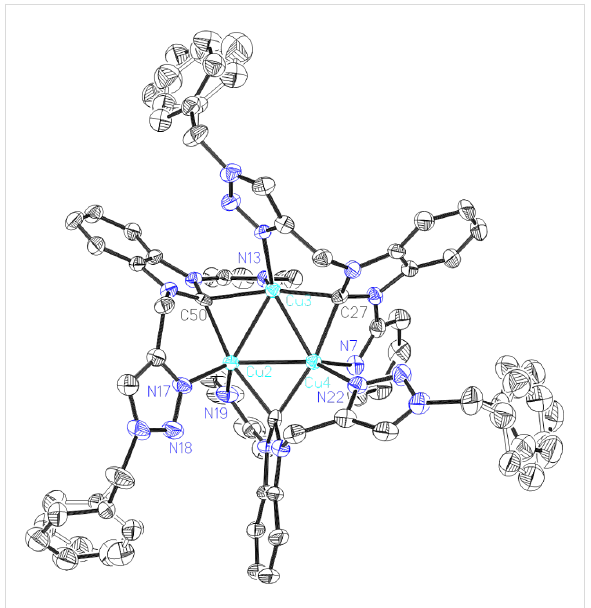
Figure 4: ORTEP drawing of [Cu 3 (L 4 ) 3 ](PF 6 ) 3 ( 5 ). Thermal ellipsoids are drawn at the 30% probability level. Hydrogen atoms and